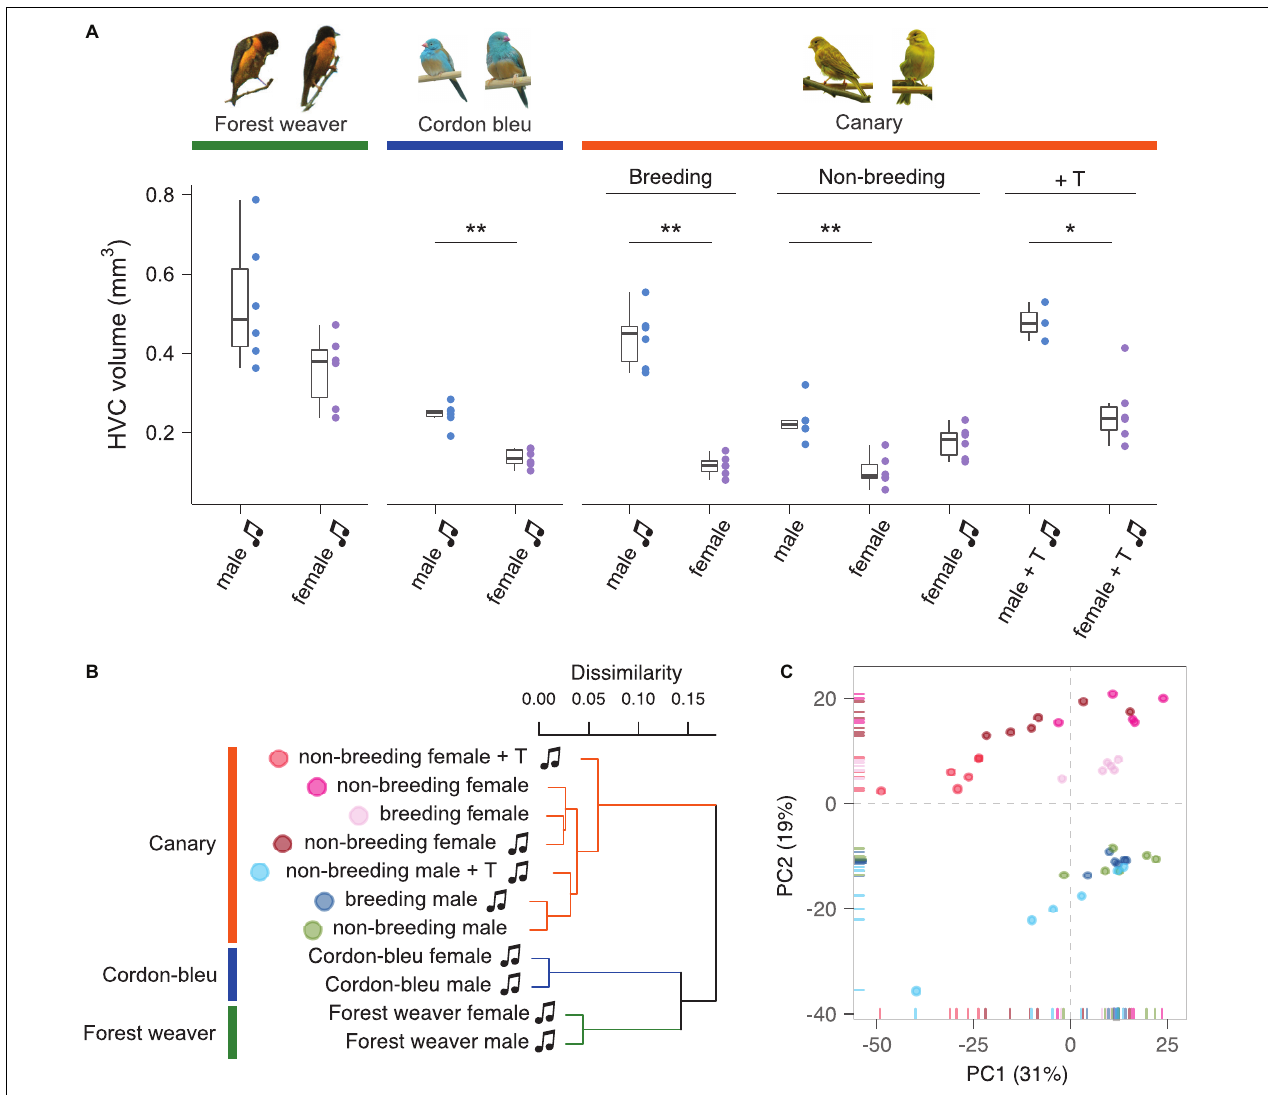
FIGURE 1 | Species, sex, and plasma androgen level are the major determinants of the HVC gene expression patterns in songbirds. (A) HVC volume of birds used in this study. Forest weavers: males 0.528 mm 3 (mean), females 0.357 mm 3 . Mann–Whitney Test, U = 7, P -value = 0.0931. Cordon-bleus: males 0.245 mm 3 , females 0.136 mm 3 . Mann–Whitney Test, U = 0, P -value = 0.00217. Breeding canaries: singing males 0.439 mm 3 , non-singing females 0.116 mm 3 . Mann–Whitney Test, U = 0, P -value = 0.00217. Non-breeding canaries: non-singing males 0.228 mm 3 , non-singing females 0.103 mm 3 , singing females 0.176 mm 3